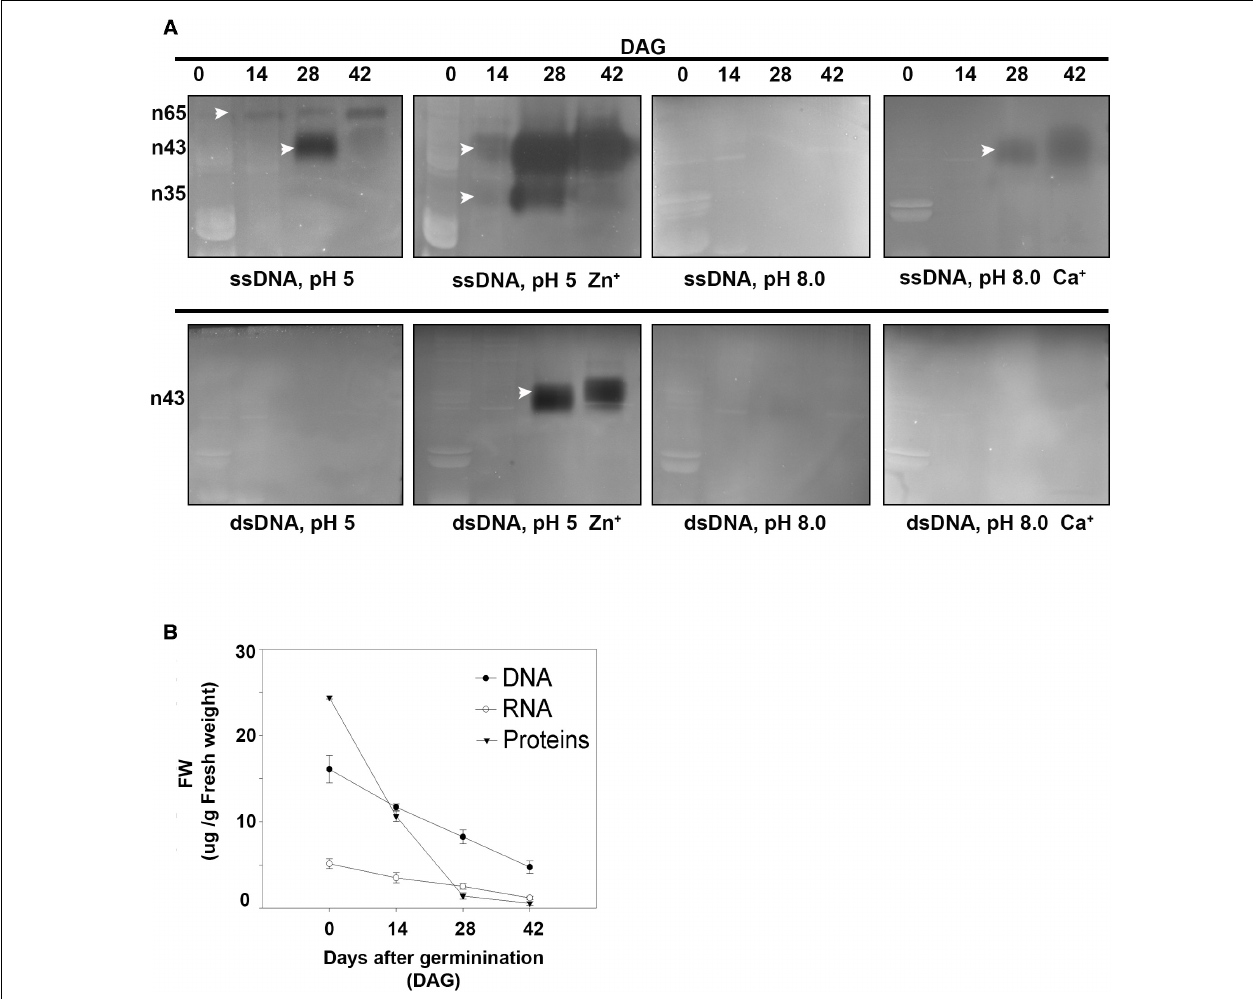
FIGURE 4 | (A) Determination of nuclease activity in A. angustifolia megagametophytes at 0, 14, 28, and 42 days after germination (DAG) by using the in-gel activity assay with ssDNA or dsDNA as substrate. See section “Materials and Methods” for detailed reaction conditions. Analyses were repeated at least three times on independent biological samples, and representative results are shown. (B) Changes in soluble protein, DNA and RNA in the megagametophyte, during germination. The three parameters exhibited a marked decrease initiated before 14 DAG. DNA, RNA, and soluble proteins were extracted at 0, 14, 28, and 42 DAG, quantified, and normalized on fresh weight. Data are represented as the mean ± standard error from three independent biological